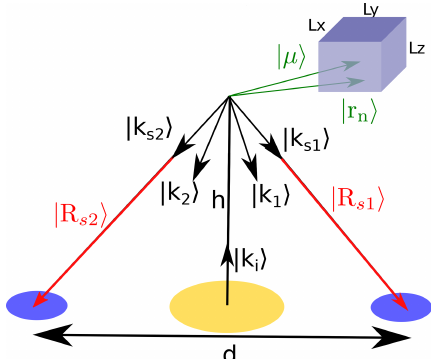
Figure 3. Set-up for calculating the cross-correlation function. The box represents an ionospheric feature with size L. The figure is based on the assumptions at the end of Sect. 2 but is not to